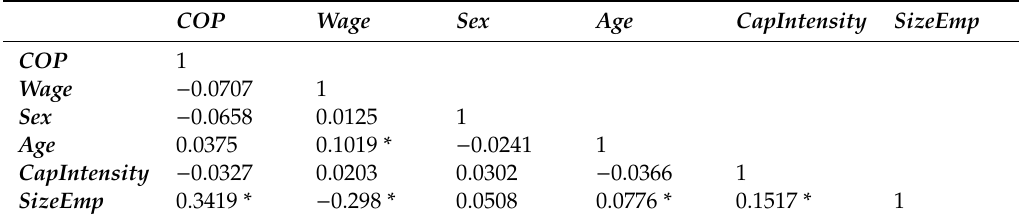
Table 2. Correlation matrix of the independent variables.